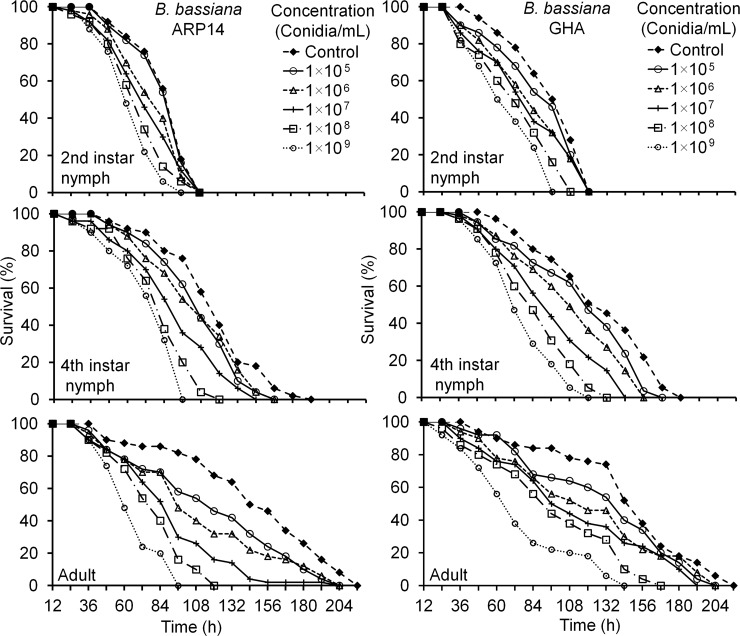
Survivorship of different life stages of Riptortus pedestris exposed to different concentrations of Beauveria bassiana of the ARP14 or GHA strains.